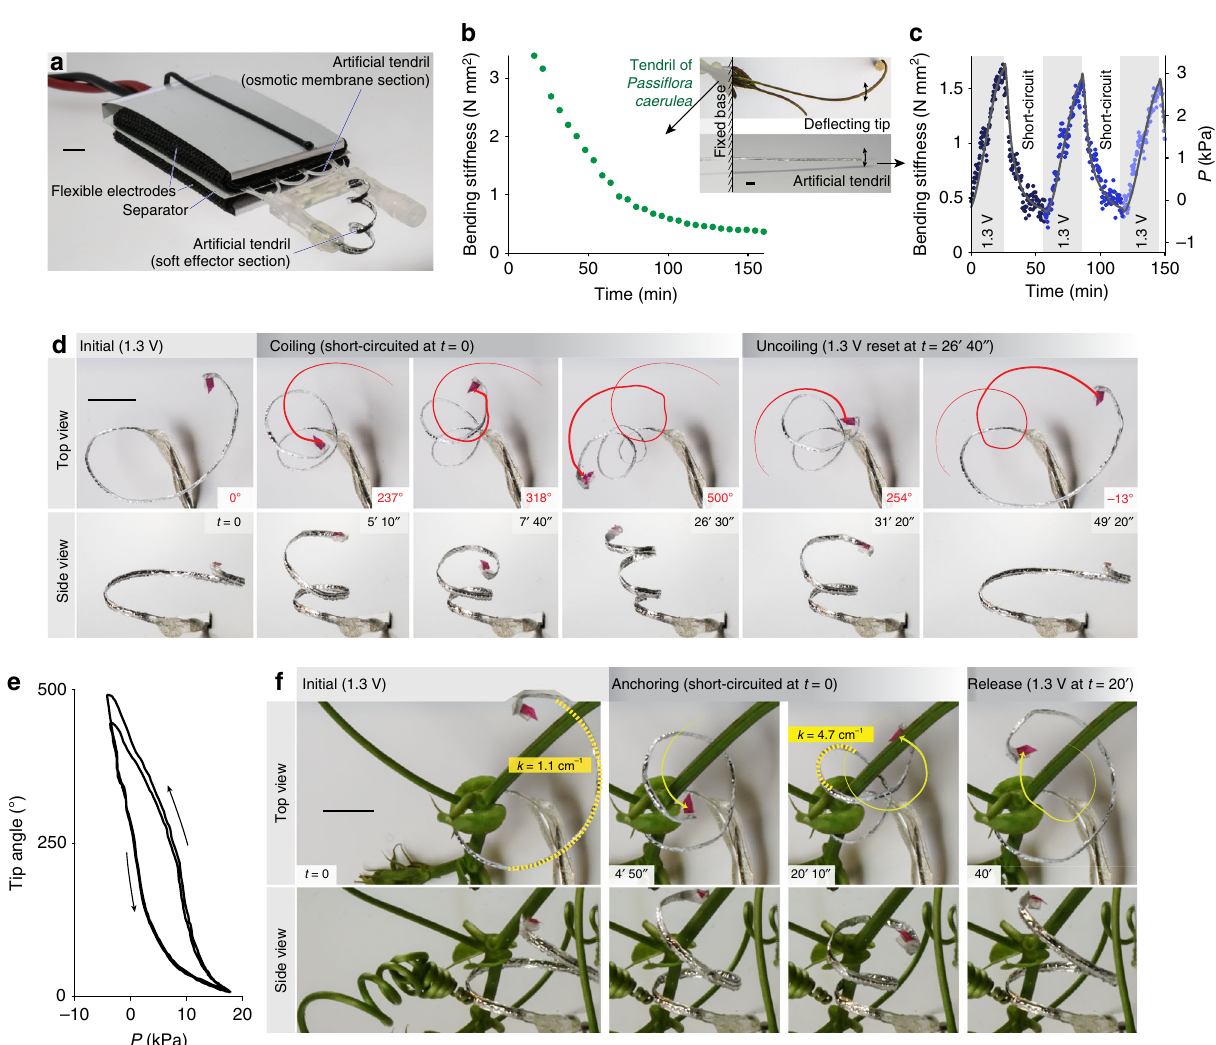
Fig. 4 Reversible stiffness modulation and actuation of a tendril-like soft robot. a Tendril-like soft robot based on the osmotic actuator. A section of the tendril (the one snaking in-between the ACCEs layers) acts as osmotic membrane, another provides the soft effector. b , c Bending stiffness vs. time. b for a cut tendril of Passi fl ora caerulea (turgor decrease caused by dehydration), and c for the soft robot (reversible stiffness modulation, also correlated to turgor P , driven by the input voltage). d Tip rotation angle at selected times: the soft robot reversibly spanned ~500 deg over ~25 min. e Tip rotation angle vs. turgor, showing good repeatability. f Strong (~5-times) change in curvature ( k ) featured by the soft robot during reversible coiling (around a Passi fl ora caerulea stem). Scale bars: 5